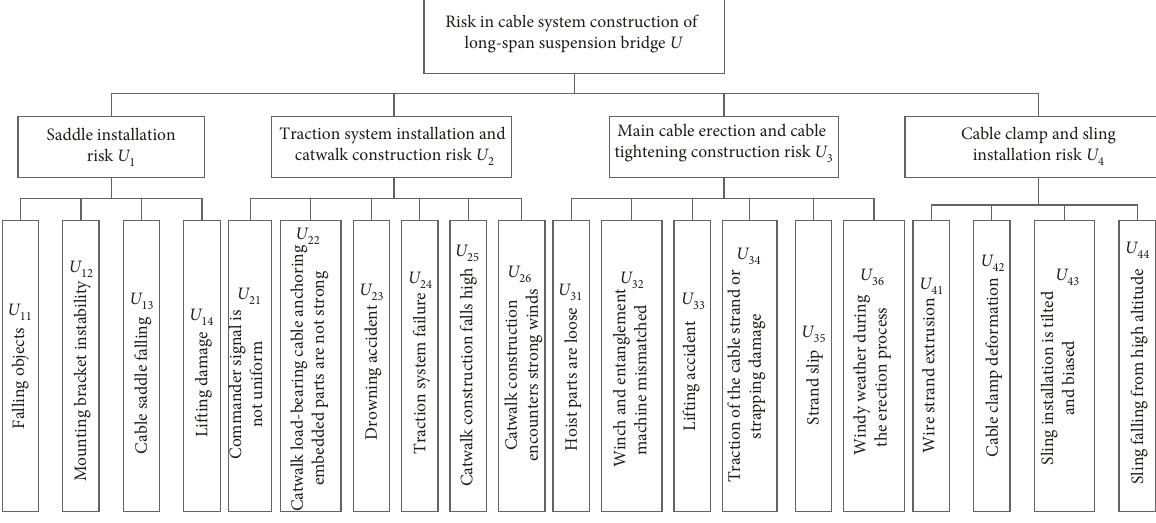
Figure 1: Cable system construction risk evaluation index system of the suspension bridge. Table 1: Value form of risk-level reliance cloud.